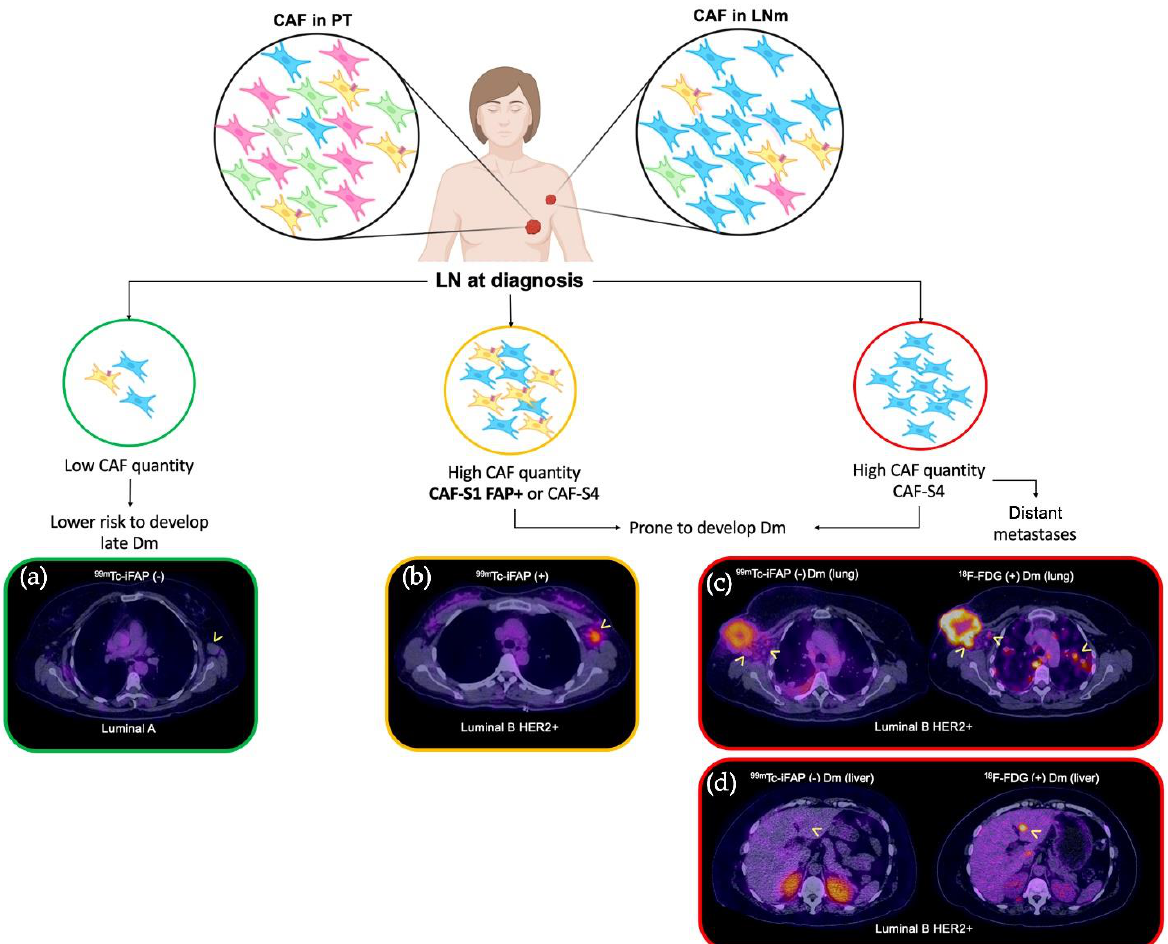
Figure 8. CAF subpopulations as prognostic markers in breast cancer (in diagnosis). Four CAF subpopulations have been reported in the lymph node metastases of breast cancer (CAF-S1 to CAF-S4). The most relevant and predominant are CAF-S1 FAP+ and CAF-S4 FAP-. Pelon et al. [23] established a model of clinical application to the knowledge generated from the different subpopulations, in